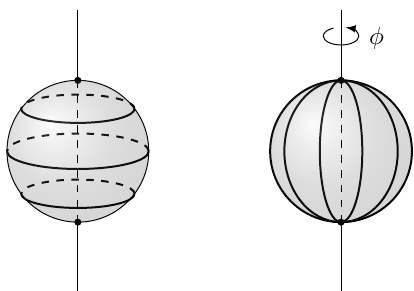
Figure 1 . The partition function of the A -model on a line bundle over S 2 has two interpretations. In the closed string channel (left), it represents the overlap h HH ∗ | HH i between the Hartle-Hawking state and its orientation reversal. In the open string channel (right), it represents a trace in the Hilbert space of open strings. Figure borrowed from ref.